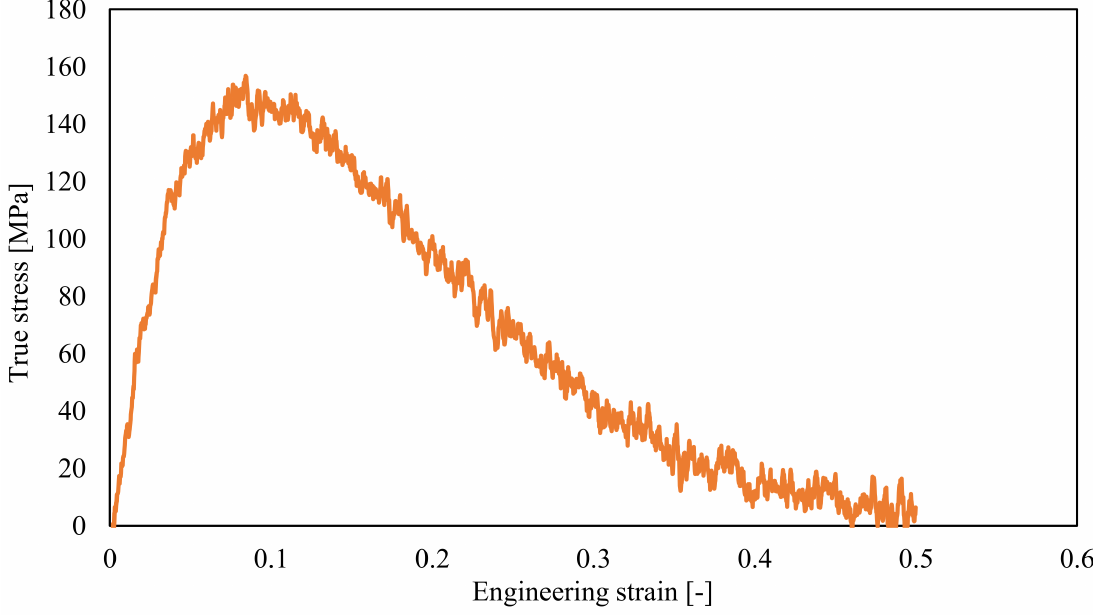
Figure 2. Stress–strain curve of PA6 obtained using MD